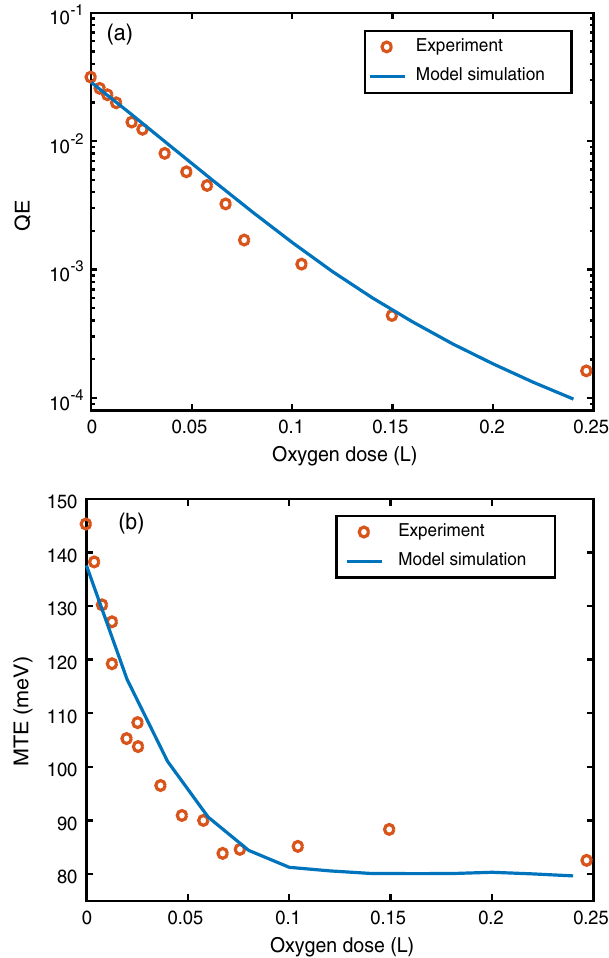
FIG. 7. The evolution of QE and MTE of GaAsP during degradation process under oxygen enriched environment ( 10 − 10 Torr) with photon energy 2.33 eV (532 nm) in the experiment [25]. (a) is about QE and (b) is about MTE. The monte carlo simulation results on QE and MTE are also presented